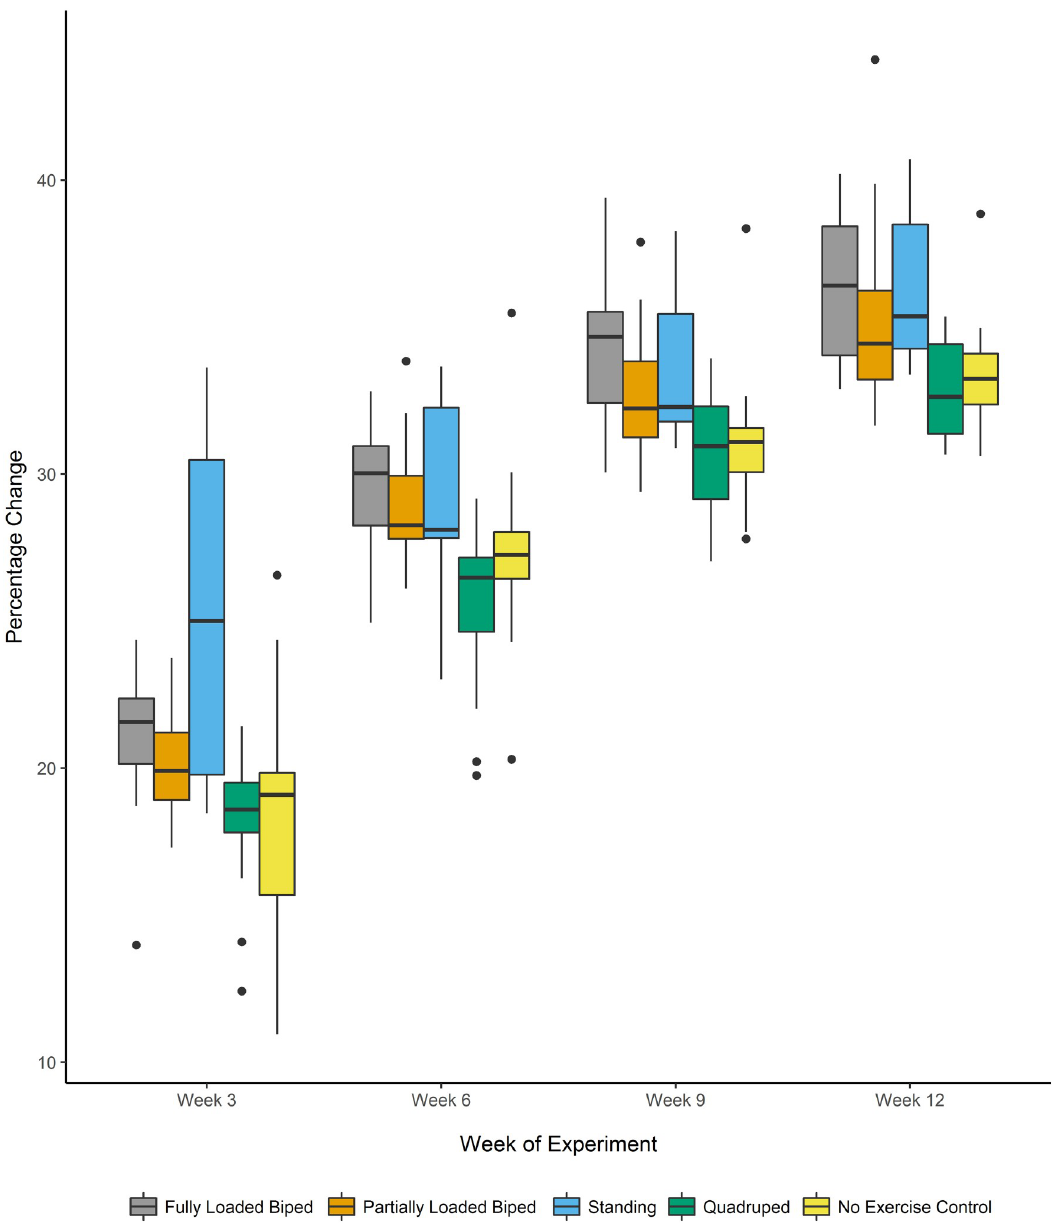
Fig 5. Percentage change in tibia length over the 12-week experiment. Boxplot of the percentage change in tibia length at weeks 3, 6, 9, and 12 relative to the length at the beginning of the experiment. The horizontal lines indicate the median, the outer boundaries of the box represent the interquartile range, the whiskers indicate the minimum and maximum, respectively, and the individual points represent